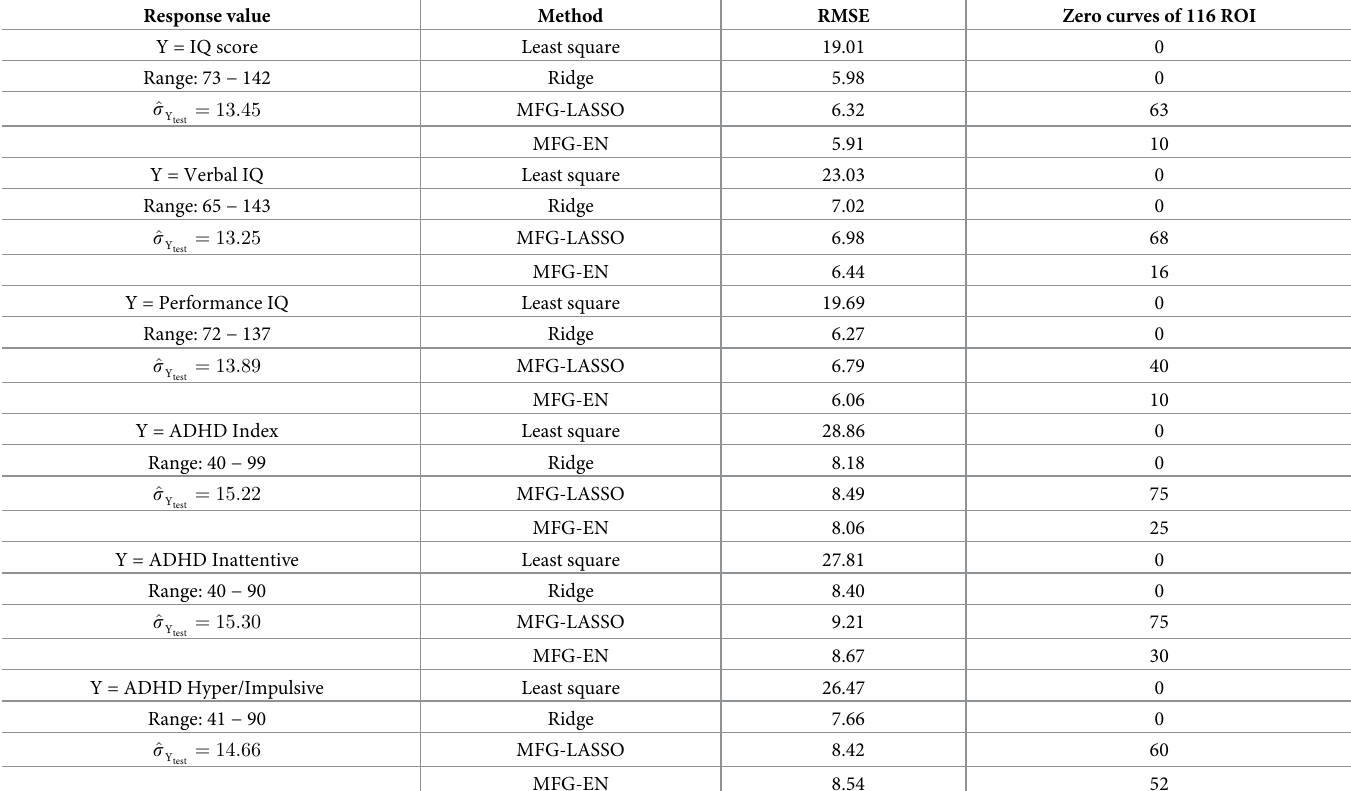
Table 3. The results of applying the proposed methods to the fMRI data when predicting the IQ and ADHD scores.